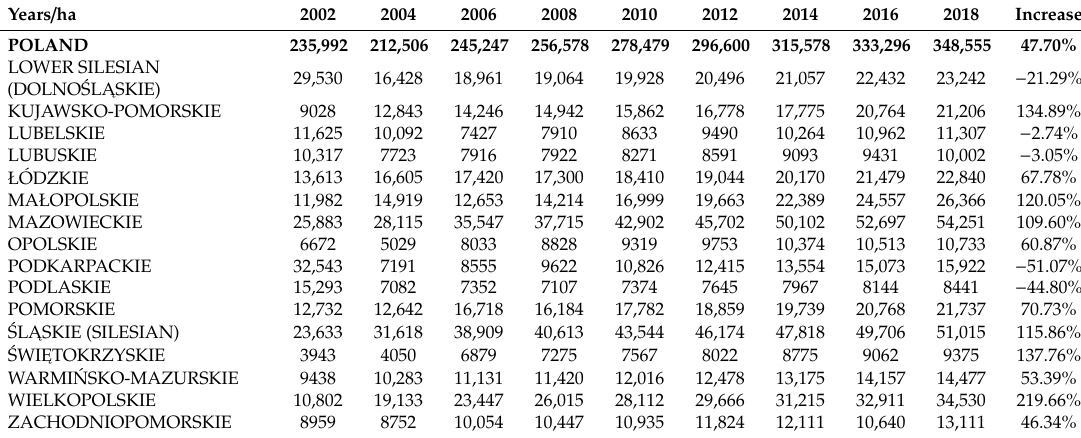
Table 1. List of urbanized and built-up land with residential function in Poland and its voivodeships in the years